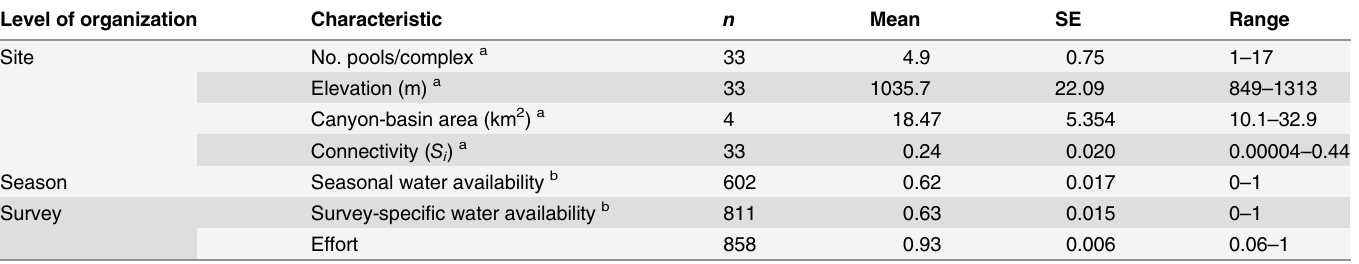
Table 1. Mean, standard error (SE), and range for site-, season-, and survey-specific characteristics used to explain variation in initial abundance, recruitment, survival, and detection probability of adult lowland leopard frogs between 1996 and 2011 in the Rincon Mountains, Arizona, USA. Level of organization